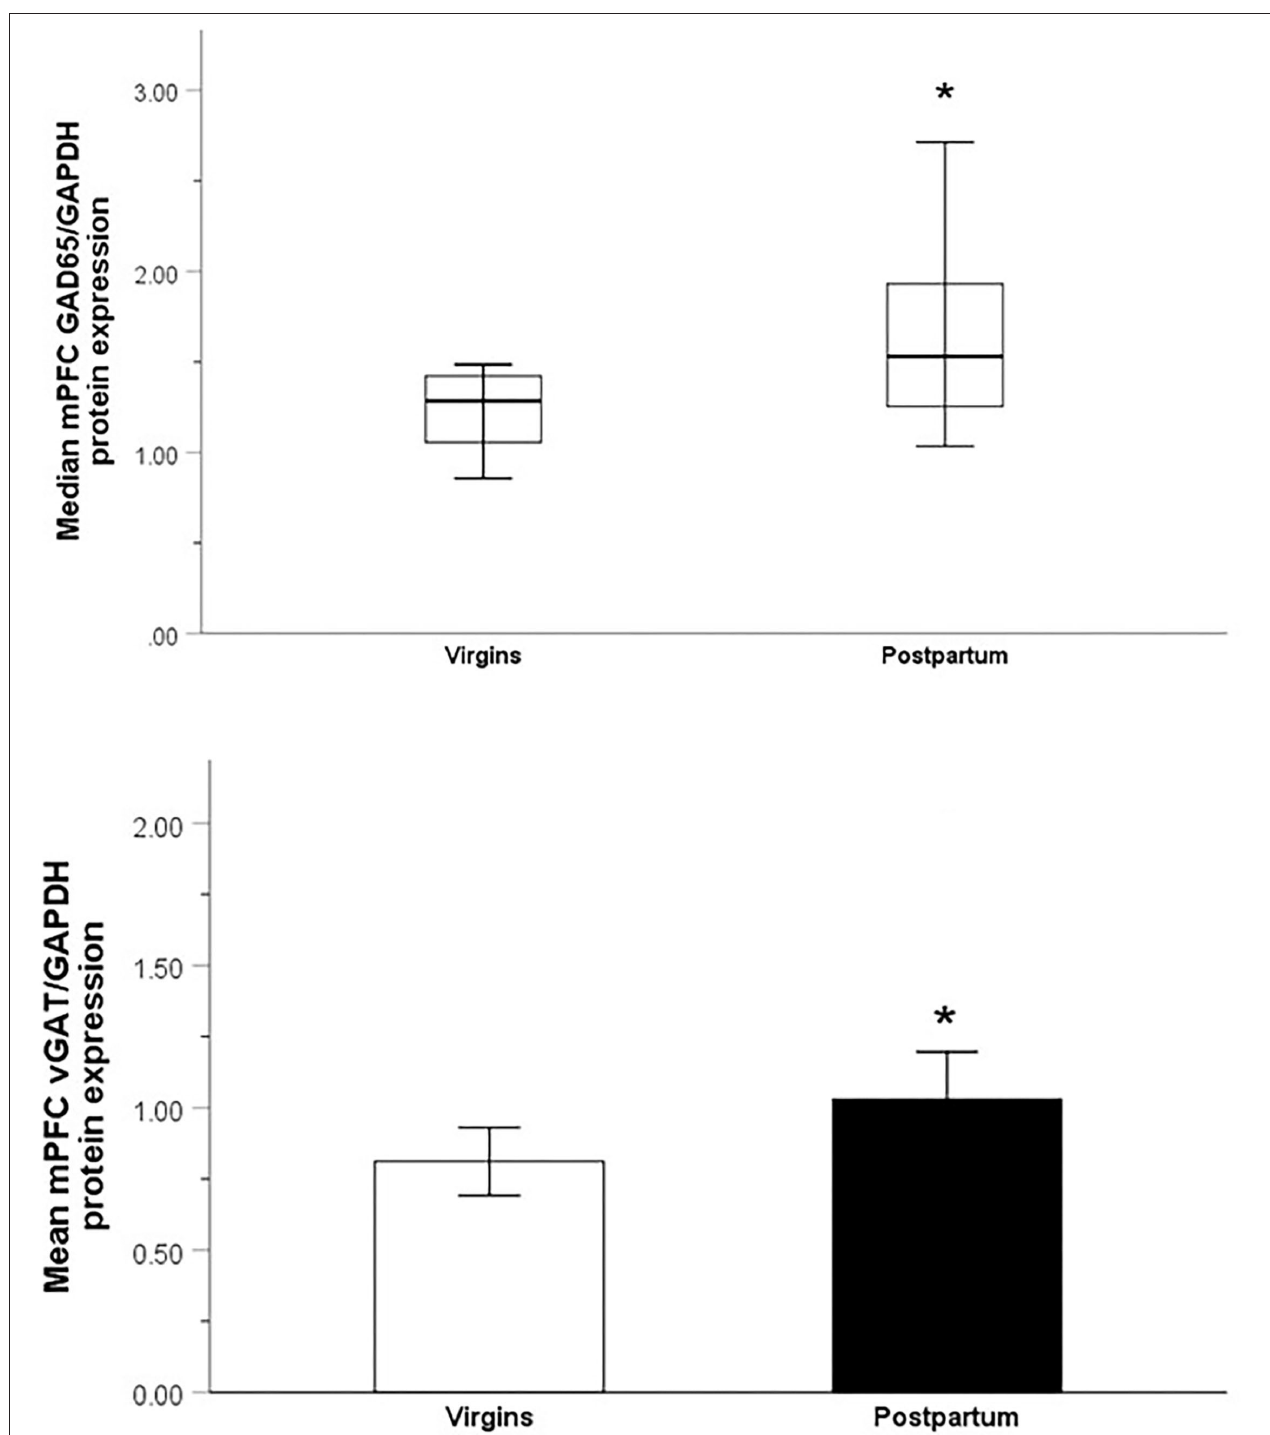
FIGURE 3 | Relative optical density of GAD 65 -immunoreactive bands (top; Median ± IQR) and vGAT-immunoreactive bands (bottom; Mean ± SEM) from the mPFC of nulliparous virgin and postpartum rats. * p < 0.05.